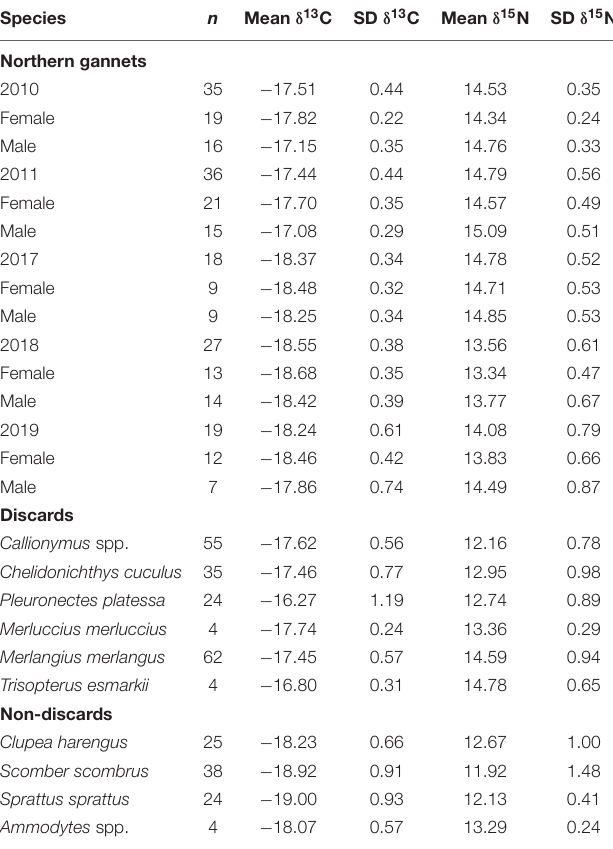
TABLE 1 | Descriptive table of stable isotope data used in mixing